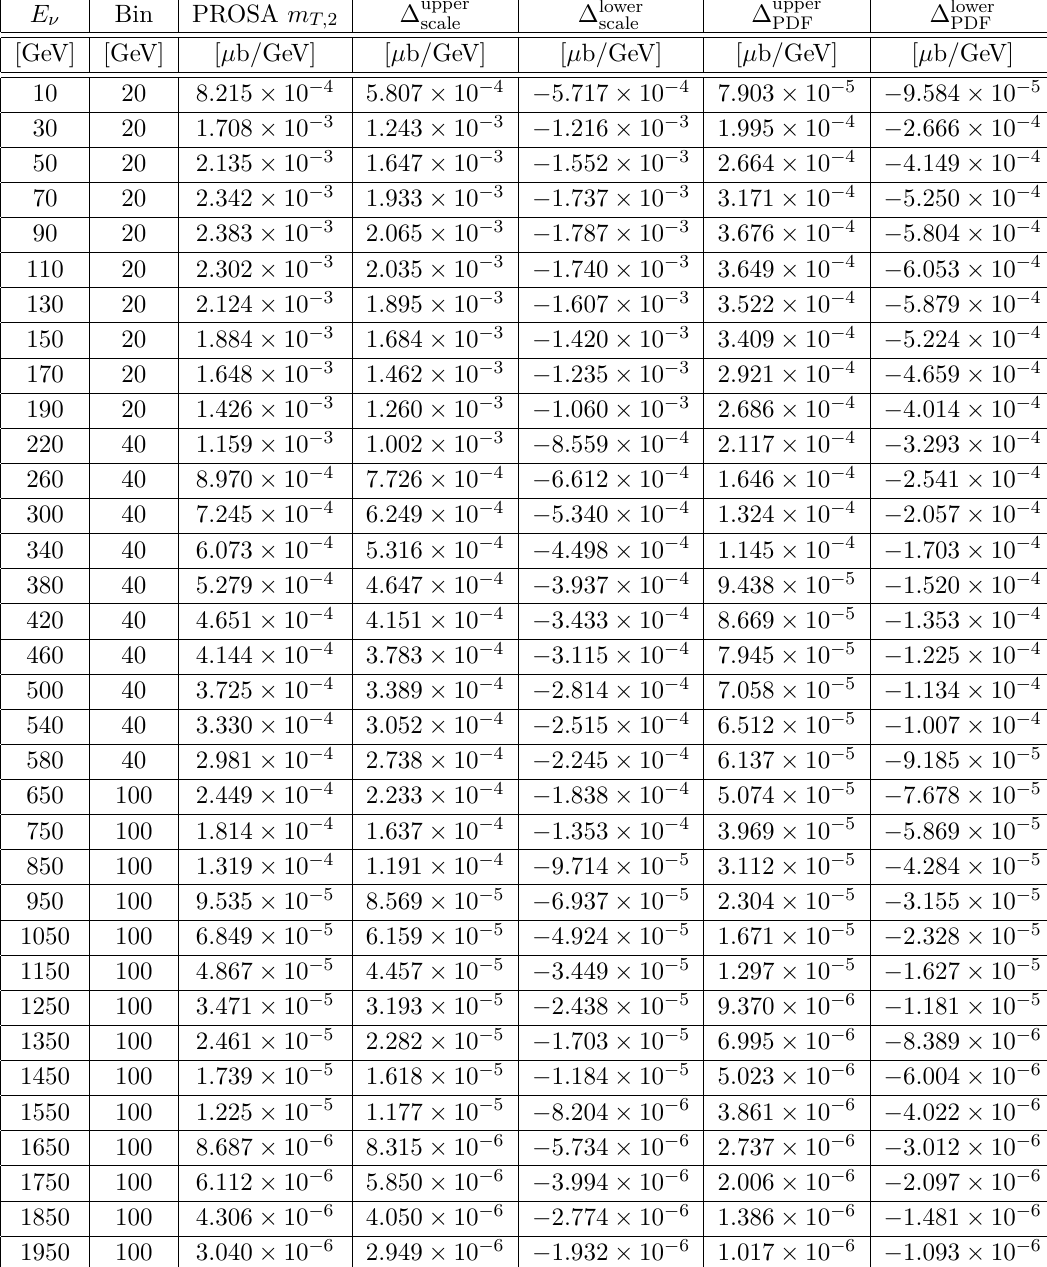
√ s = 14 TeV, 7 . 2 < η ν < 8 . 6 .